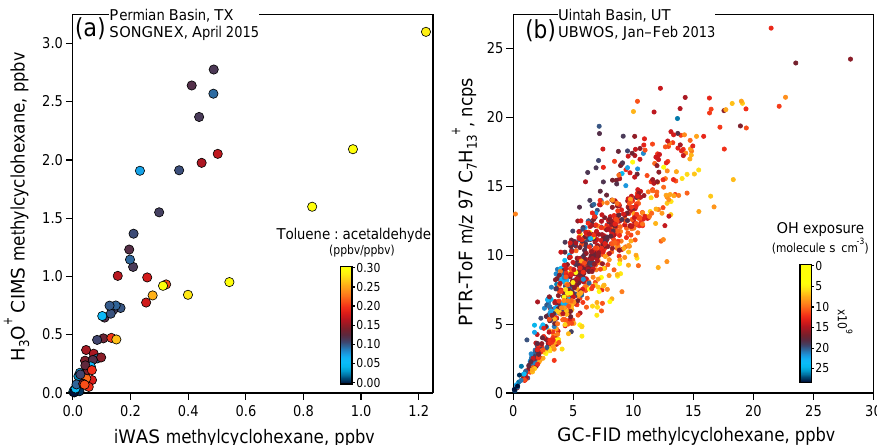
Figure 9. Comparison between PTR-ToF-MS and GC measurements of methylcyclohexane. (a) SONGNEX 2015. (b) UBWOS 2013.